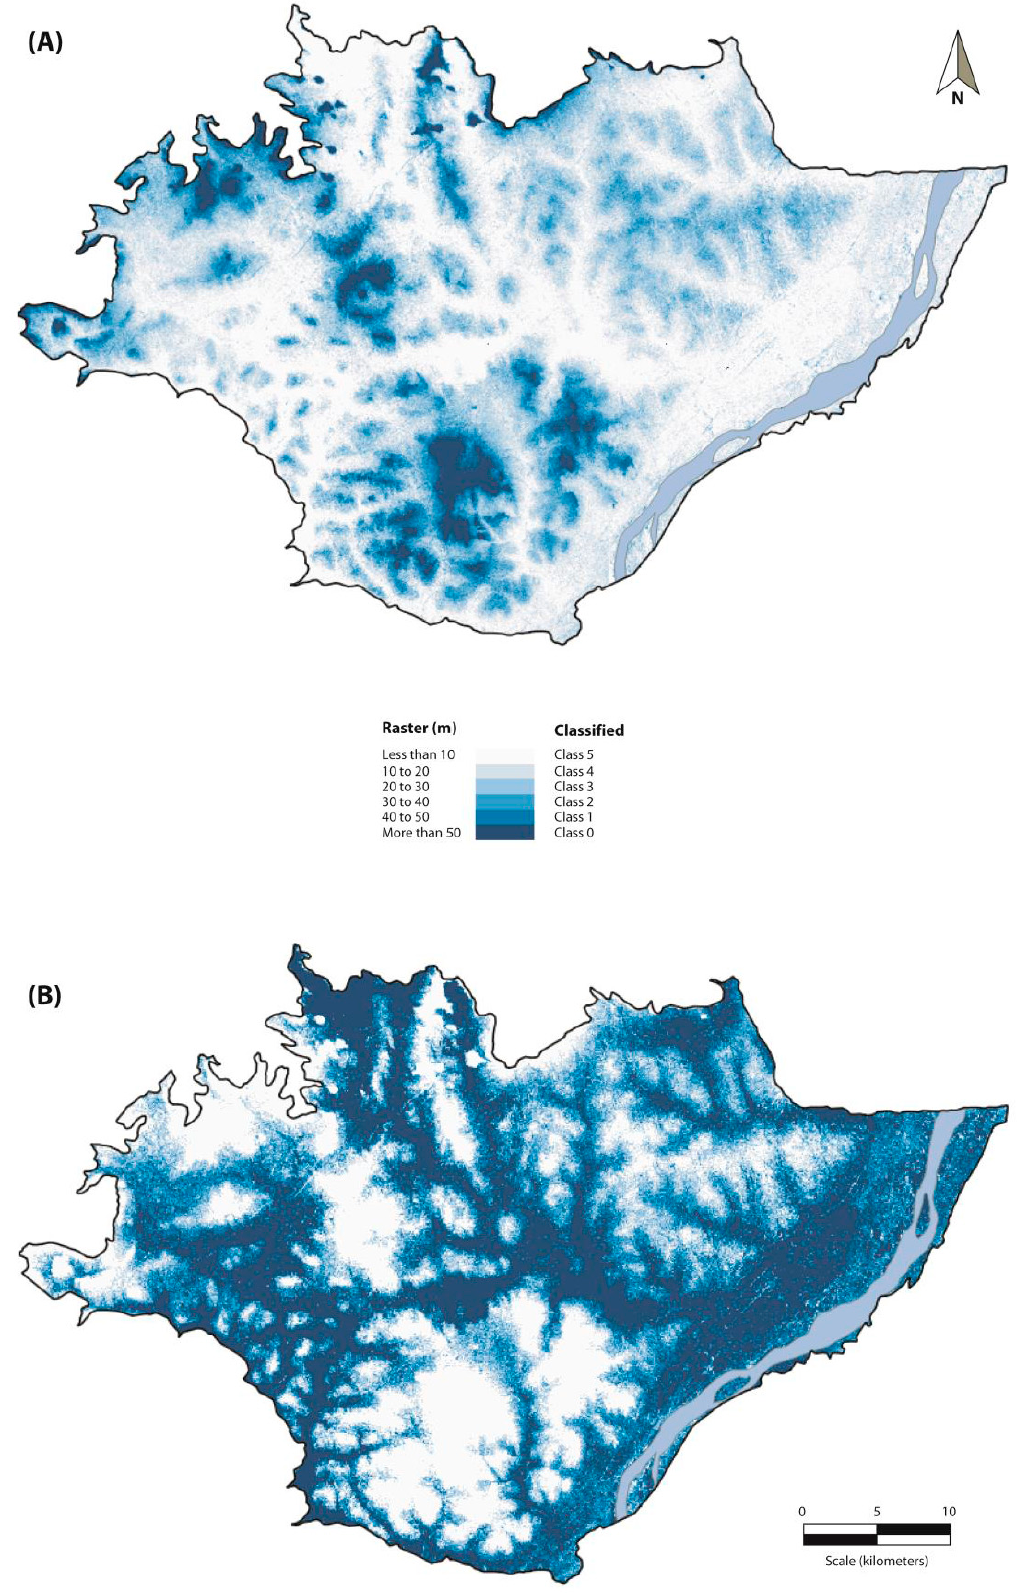
Figure 8. ( A ) Raster and ( B ) classified outcome for the water table depth.